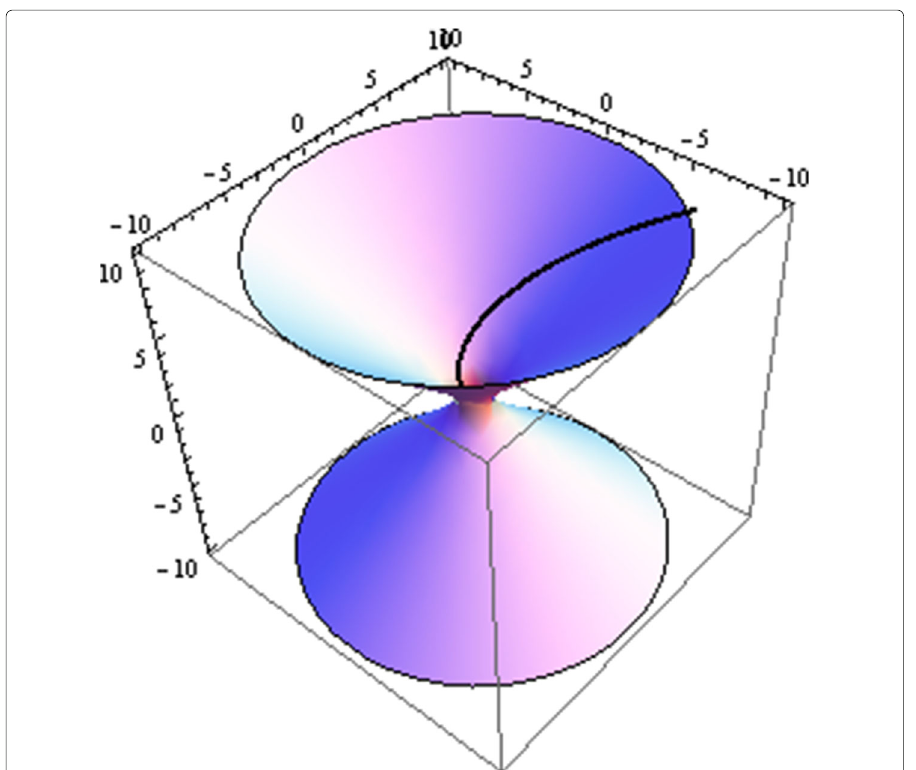
Fig. 1 Spacelike curve r = r ( s ) on S 2